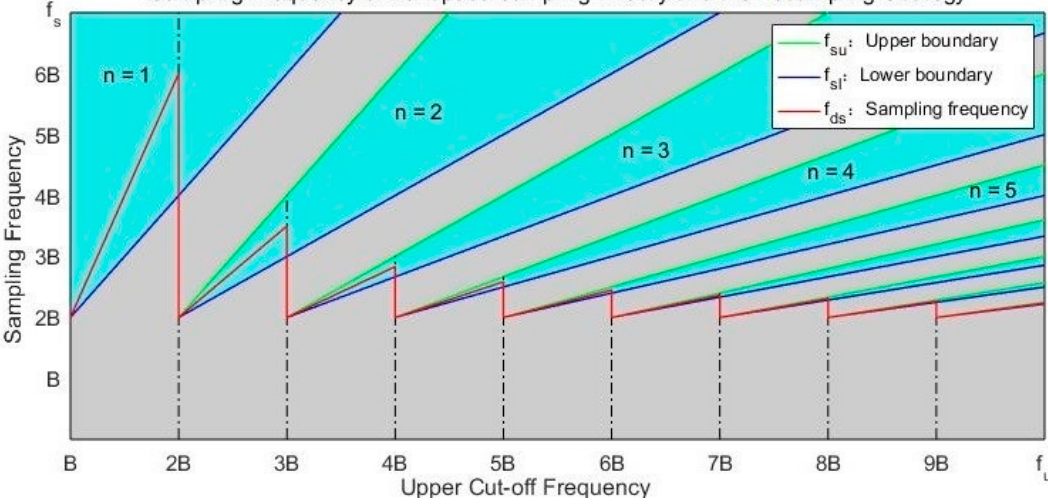
Figure 2. Acceptable sampling frequency (cyan areas) based on the bandpass sampling theory. Blue and green lines are lower and upper boundaries of the acceptable sampling frequency. The red line indicates the resampling frequency of the proposed